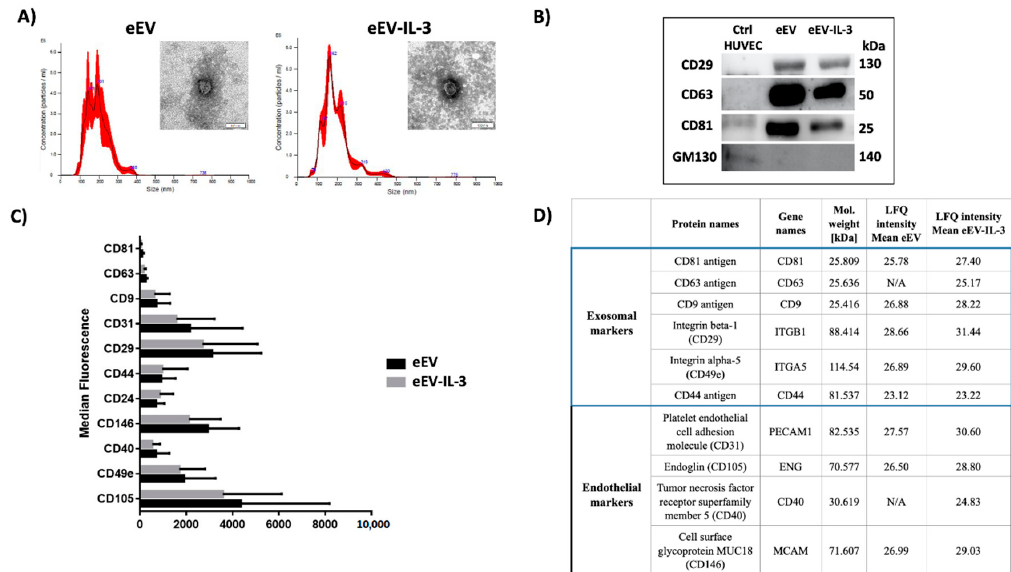
Figure 1. Endothelial cell-derived extracellular vesicles (eEV) and eEV released in response to interleukin-3 (eEV-IL-3) characterization. ( A ) Representative images of NanoSight analyses and TEM performed on eEV and eEV-IL-3. ( B ) Western blot. Representative images of exosomal markers, CD29, CD63, and CD81, expressed in eEV and eEV-IL-3. GM130 protein expression served as a negative EV marker. Indeed, it was expressed only in the cell extract (Ctrl Human Umbilical Vein Cells (HUVEC)). ( C ) eEV and eEV-IL-3 characterization with MACSPlex Exosome Kit. ( D ) The table reports the expression of eEV and eEV-IL-3 exosomal and endothelial markers provided by mass spectrometry.